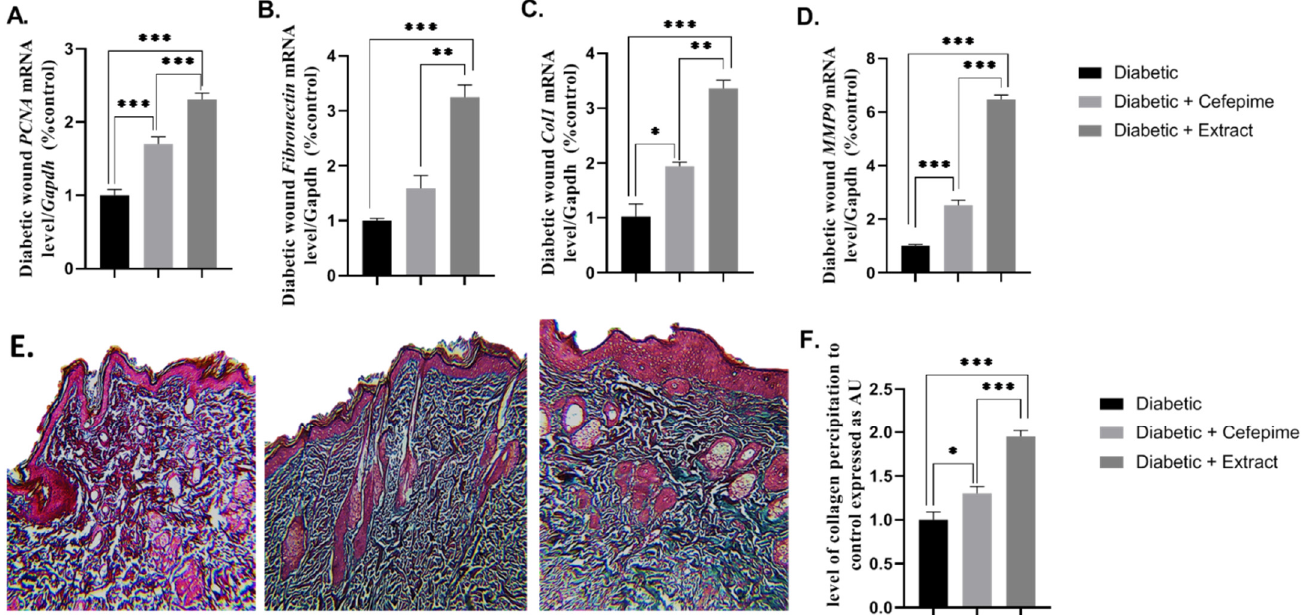
Figure 4. Effect of the hydrogel topical application of cefepime and CFE once daily for 14 successive days on the mean fold change of the, mRNA relative expression of regenerative markers ( PCNA , Fibronectin , COL1 , and MMP9 ) to internal control gene Gapdh ( A – D ) and collagen deposition ( E , F ) of a diabetic wound infected with clinical isolates of P. Mirabilis infected with LC587231 in Type 1 diabetic rats. ( A ) mRNA relative expression of PCNA to internal control gene Gapdh , ( B ) mRNA relative expression of Fibronectin to internal control gene Gapdh , ( C ) mRNA relative expression of COL1 to internal control gene Gapdh , ( D ) mRNA relative expression of MMP9 to internal control gene Gapdh , ( E ) a photomicrograph of Masson blue staining of: control group (left panel), cefepime-treated group (middle panel), and CFE-treated group (right panel), and ( F ) for the level of the collagen deposition.